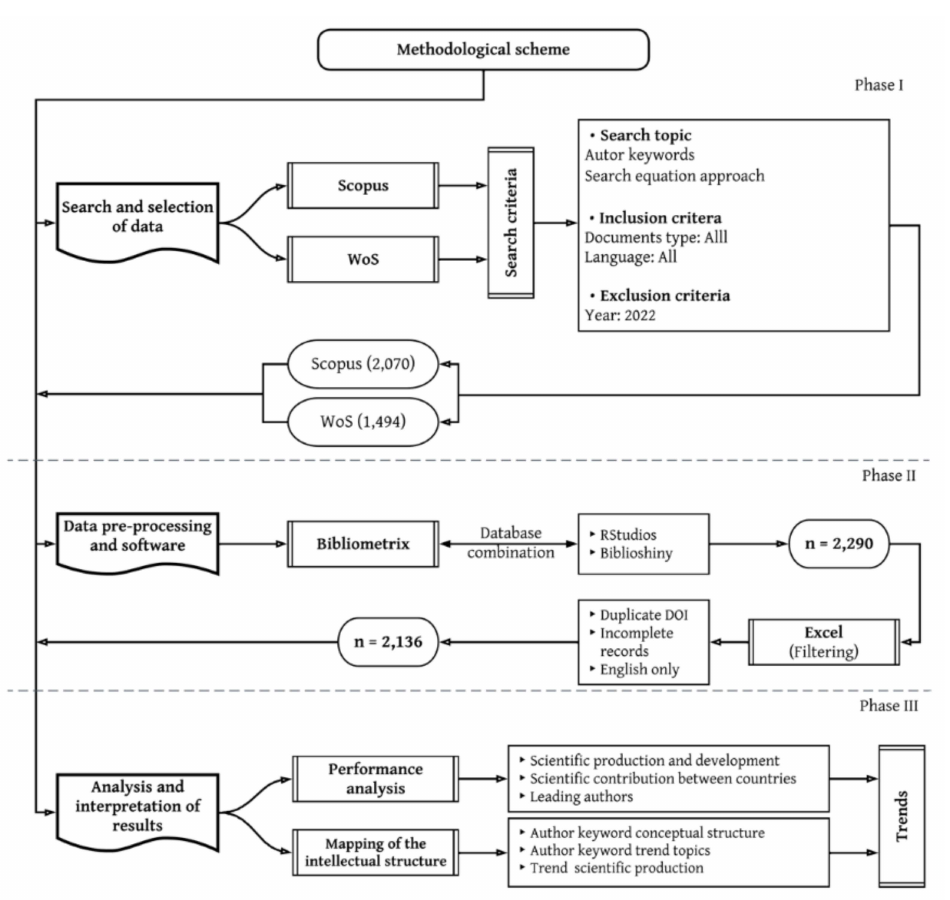
Figure 1. Methodological outline for bibliometric analysis and mapping of the research